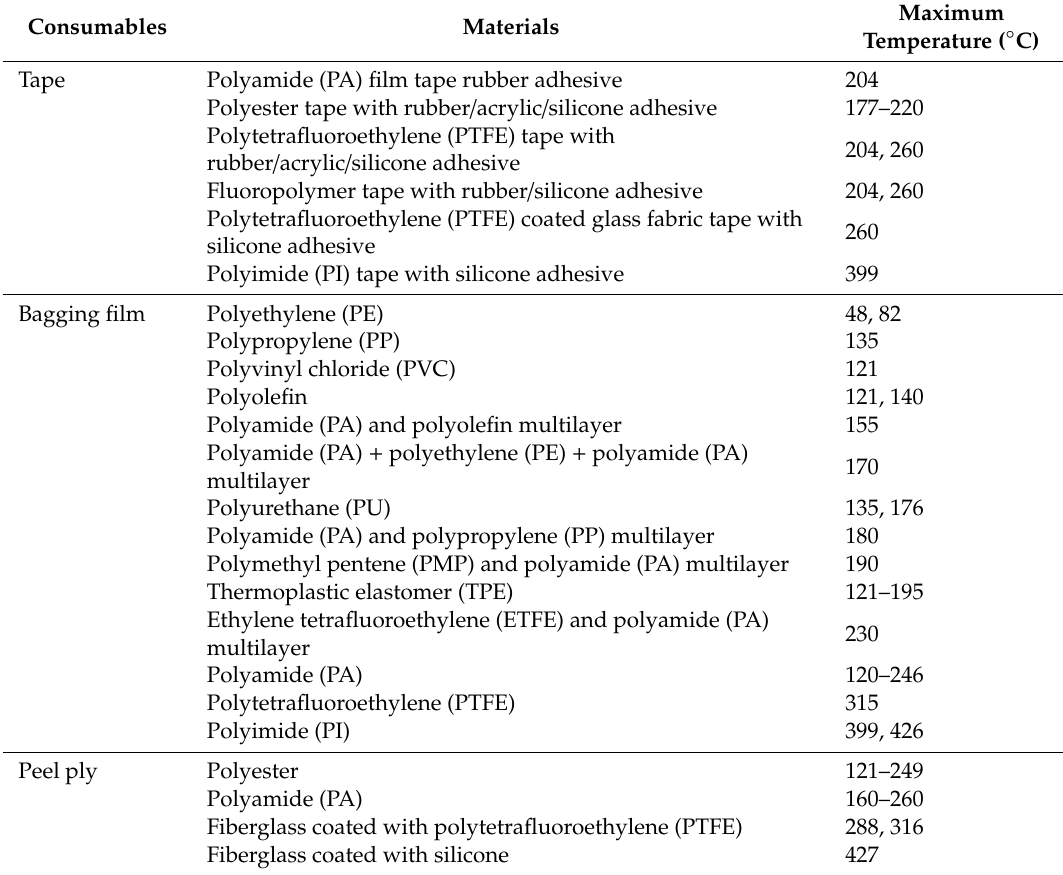
Table 1. Commercial consumables for RIFT, and their maximum working temperatures